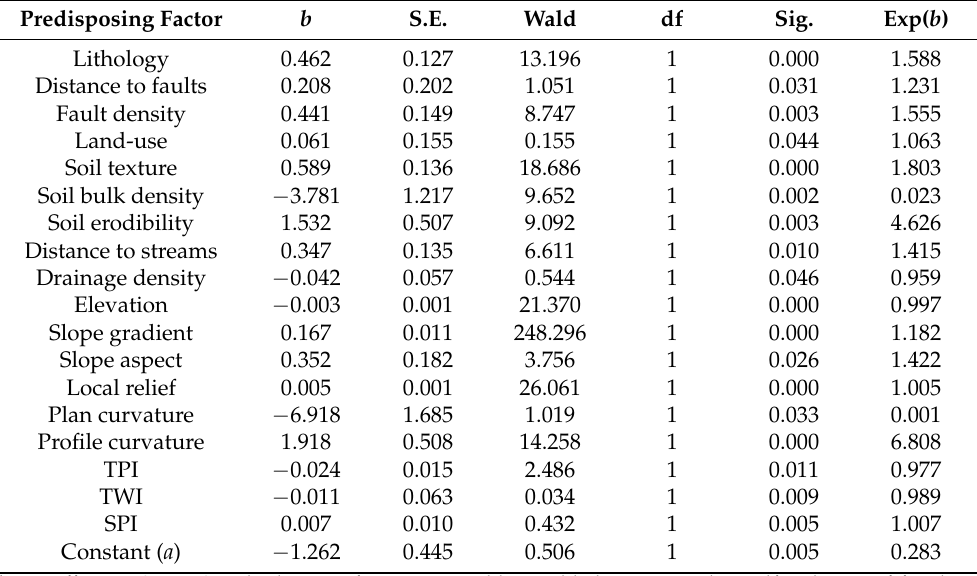
Table 6. Coefficients and test statistics of the predisposing factors used in the logistic regression